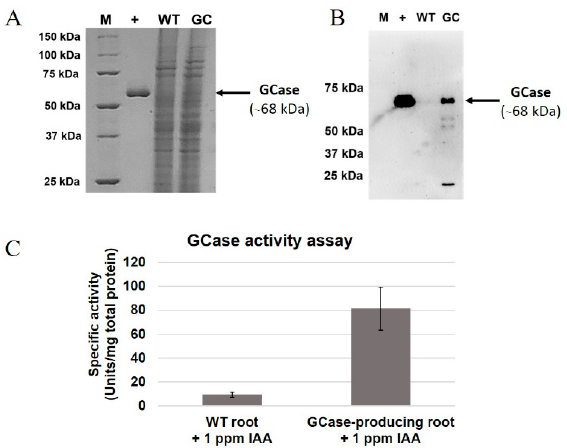
Figure 2 . Analysis of GCase produced from root culture . The panels show the results of ( A ) sodium dodecyl sulfate polyacrylamide gel electrophoresis (SDS-PAGE) analysis and ( B ) Western blot analysis and ( C ) the GCase enzymatic activity of total proteins produced from wild-type (WT) and GCase-producing N . benthamiana root culture after induction by IAA (1 mg / L) . The experiment was performed in three replications . M, precision plus protein standards marker; +, Cerezyme ® ; WT, wild type; GC, GCase . Arrows indicate the GCase band (68 kDa) .